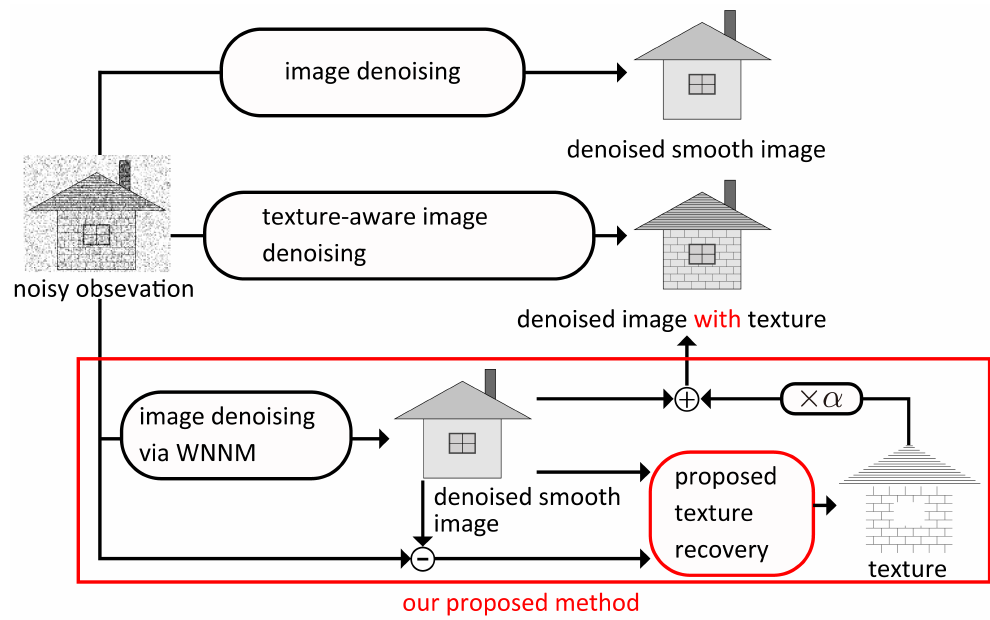
Figure 2. Scheme of our proposed texture recovery method. In contrast to existing image denoising methods [1–21], including texture-aware methods [8,19–21], our method recovers the texture from both the observed image and the denoised image obtained via WNNM